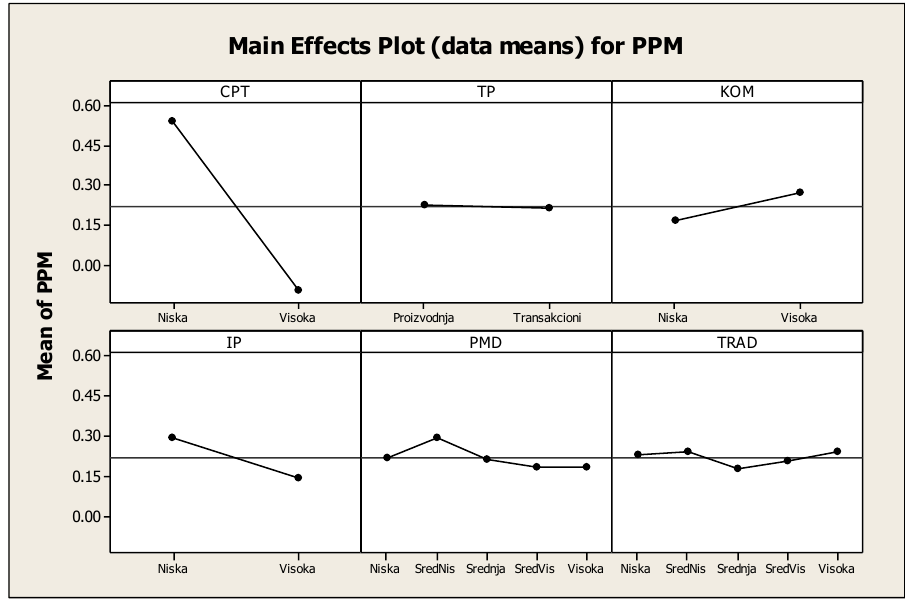
Fig. 11. PPM main effect